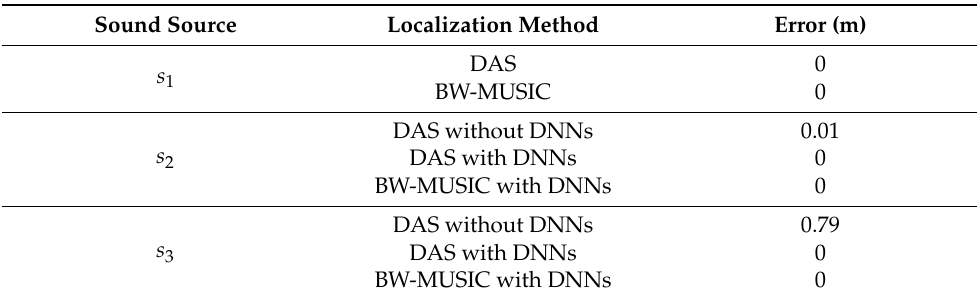
Figure 9. Beamforming maps obtained with the BW − MUSIC with DNNs. ( a ) s 1 ; ( b ) s 2 ; ( c ) s 3 .